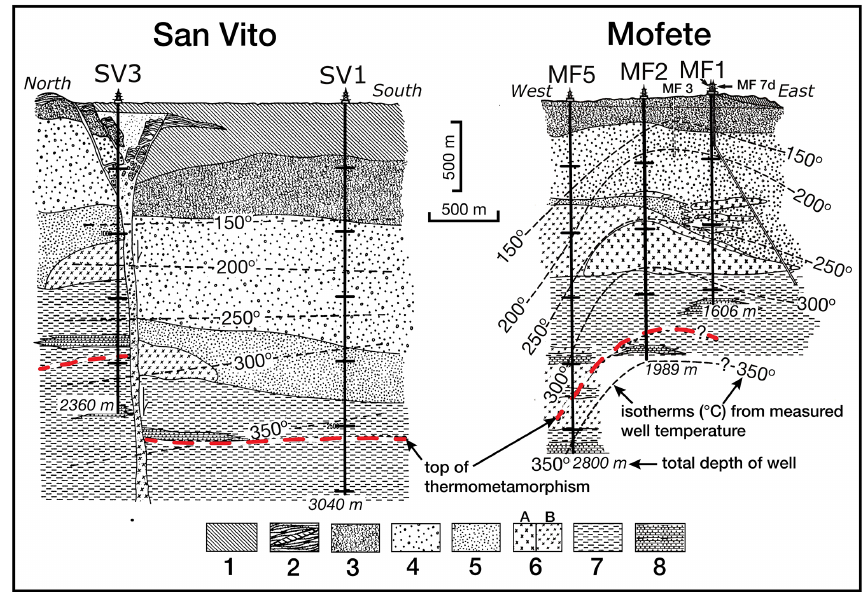
Figure 2. Schematic sketch showing generalized stratigraphy of the five geothermal wells, adapted from De Vivo et al. (1989). The top of thermometamorphism, total depth of well, and isotherms ( ◦ C) are indicated. Lithologic symbols: 1 – incoherent pyroclastic rocks; 2 – latitic soriae and pumices; 3 – yellow tuffs (post-caldera submarine activity); 4 – chaotic tuffites; 5 – chaotic tuffites (subaerial environment); 6A – trachytic lavas; 6B – latitic lavas and lava domes (pre-caldera period); 7 – interbedded tuffites, tuffs and lavas (submarine environment); and 8 – interbedded shales, marls, siltstones, and sandstones